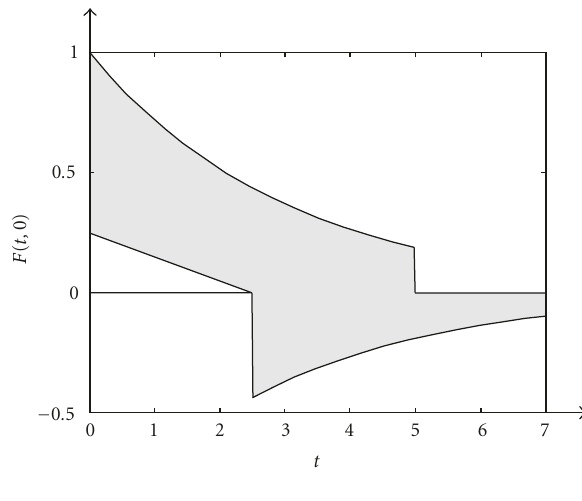
Figure 3.1. Graph of the multifunction t → F ( t